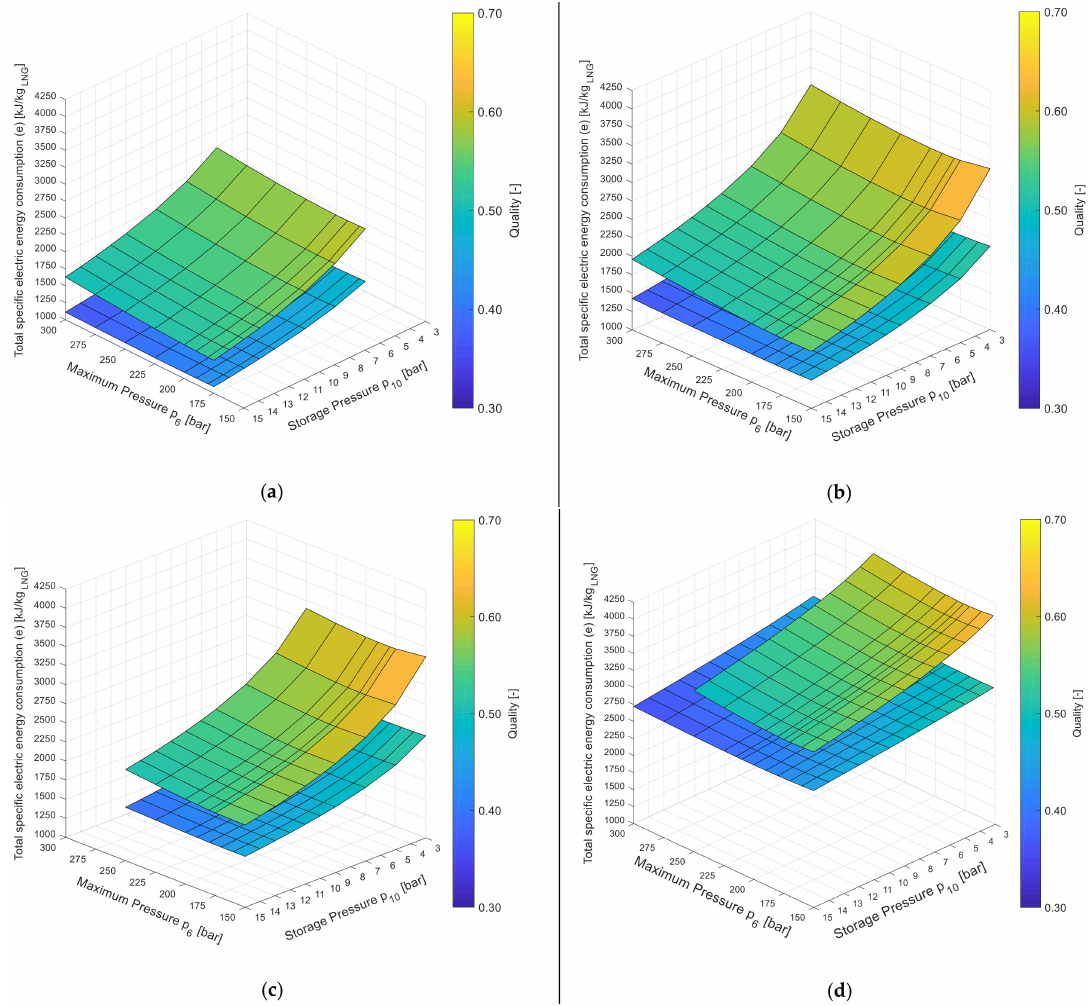
Figure 3. Total specific electric energy consumption as function of maximum pressure p 6 and storage pressure p 10 : ( a ) HPN, ( b ) MHPN, ( c ) MLPN, ( d )